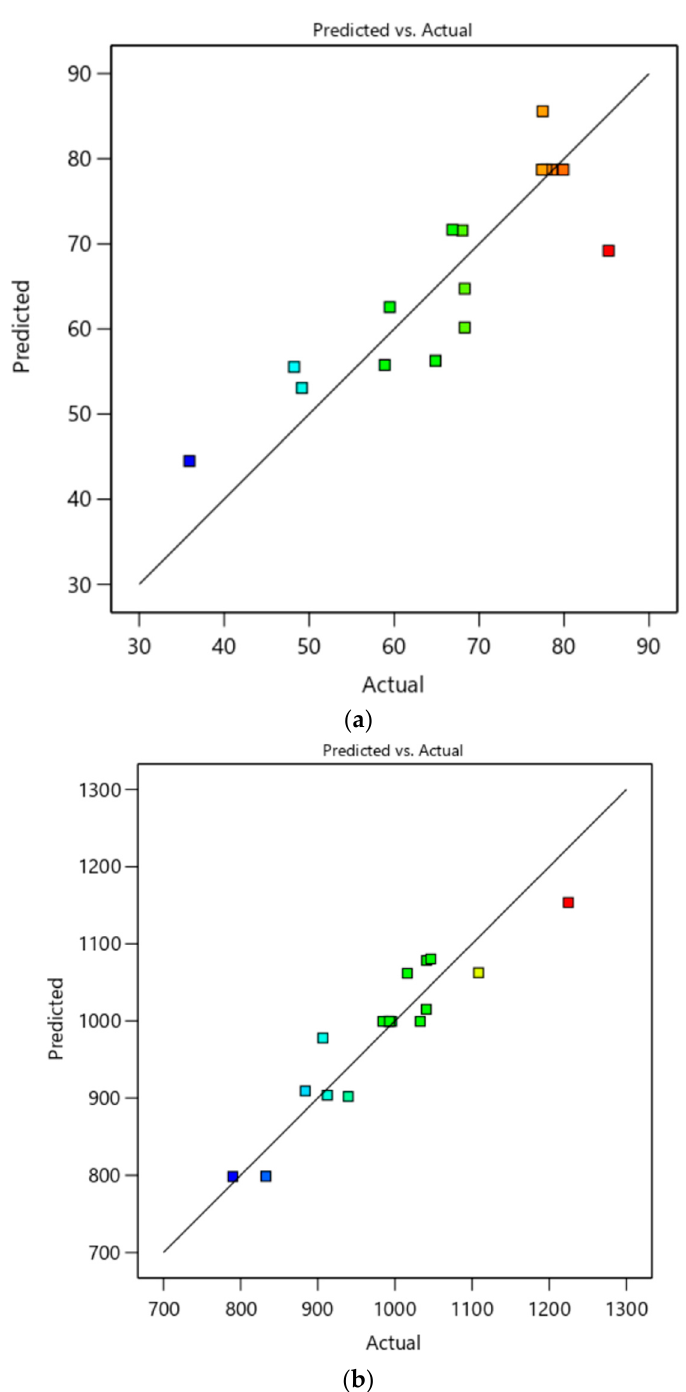
Figure 5. Predicted vs. Actual responses: ( a ) Yield and ( b ) TAC for SWE extraction.